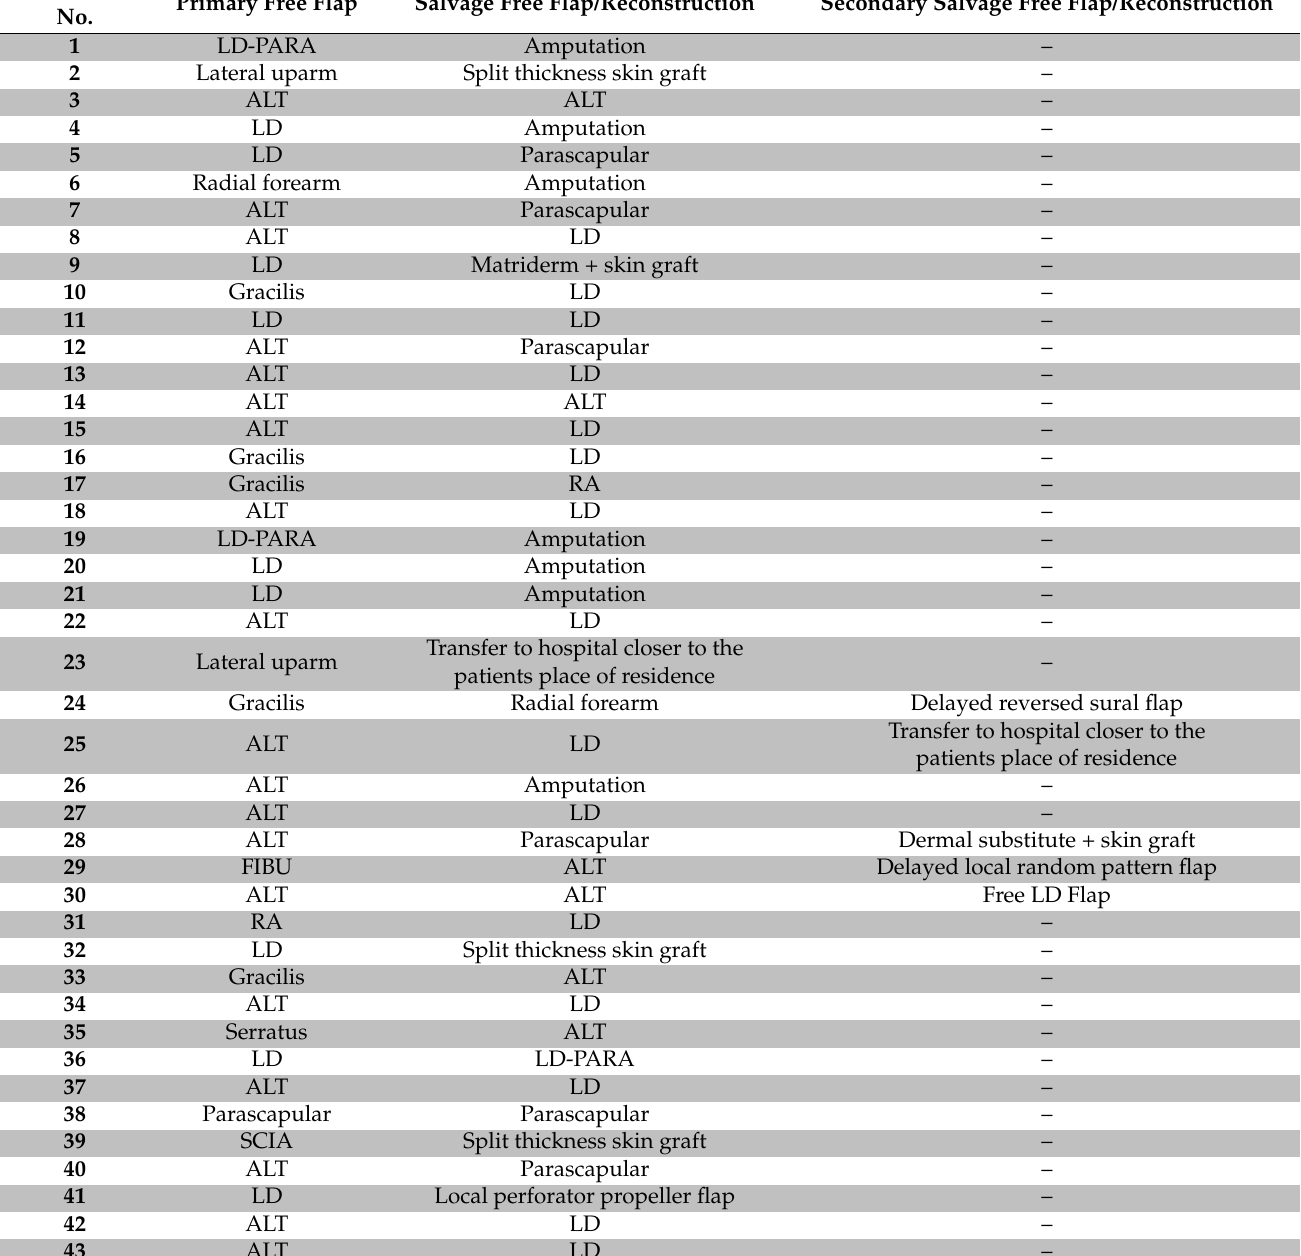
Table 2. Consecutive